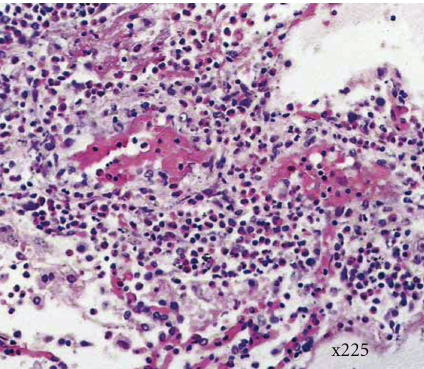
Figure 2: High-powered image of haematoxylin and eosin-stained section of a vessel with eosinophilic infiltrate and vascular distor- tion, x225